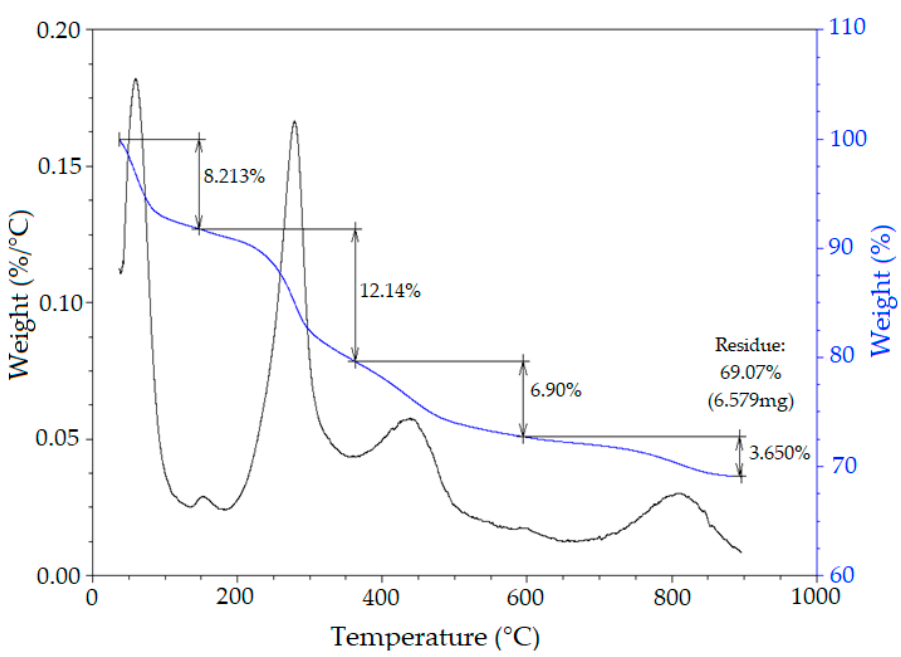
Figure 4. Thermogravimetric analysis (TGA-DTG) for K 2 CO 3 / γ -Al 2 O 3 /sepiolite/CoFe 2 O 4 .